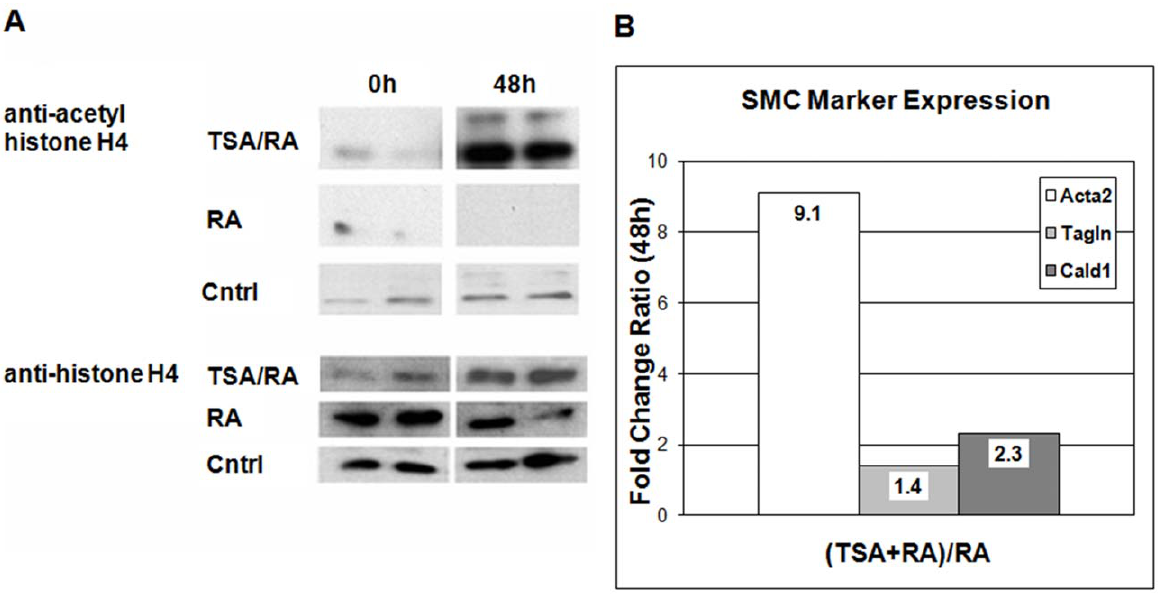
Figure 3. Trichostatin A and SMC differentiation markers. A . Western blots of A404 cell histone extract, using anti-acetyl histone H4 or anti- histone H4 primary antibody. Cntrl = Control; RA = retinoic acid; TSA/RA = trichostatin A + retinoic acid. Time 0 and 48 h of treatment are shown. B . Increased relative expression of SMC differentiation markers after 48 h in TSA + RA-treated A404 cells vs. RA-treated alone. For all ratios, p , 0.05. Acta2 = SM a -actin, Tagln = transgelin/SM22 a , Cald1 = caldesmon